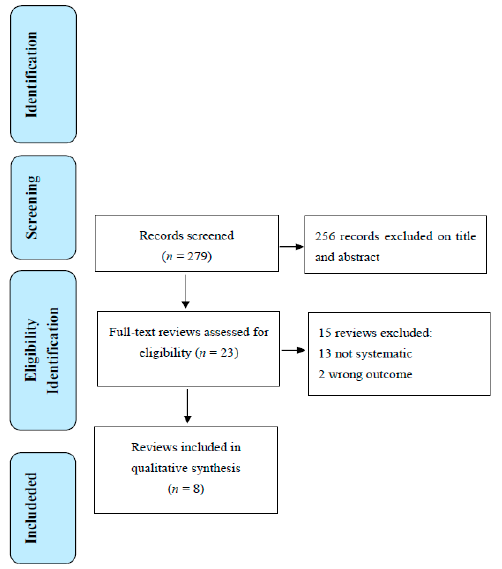
Figure 1. PRISMA (Preferred Reporting Items for Systematic Reviews) flow diagram of the selection of reviews.